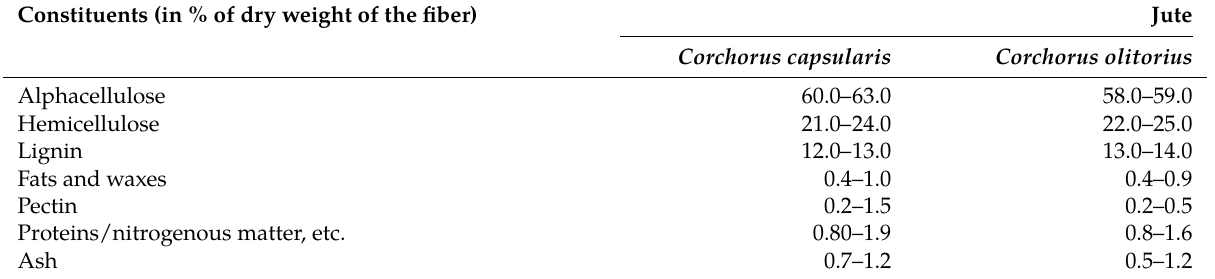
Table 2: Chemical composition of jute fiber [24]. Constituents (in % of dry weight of the